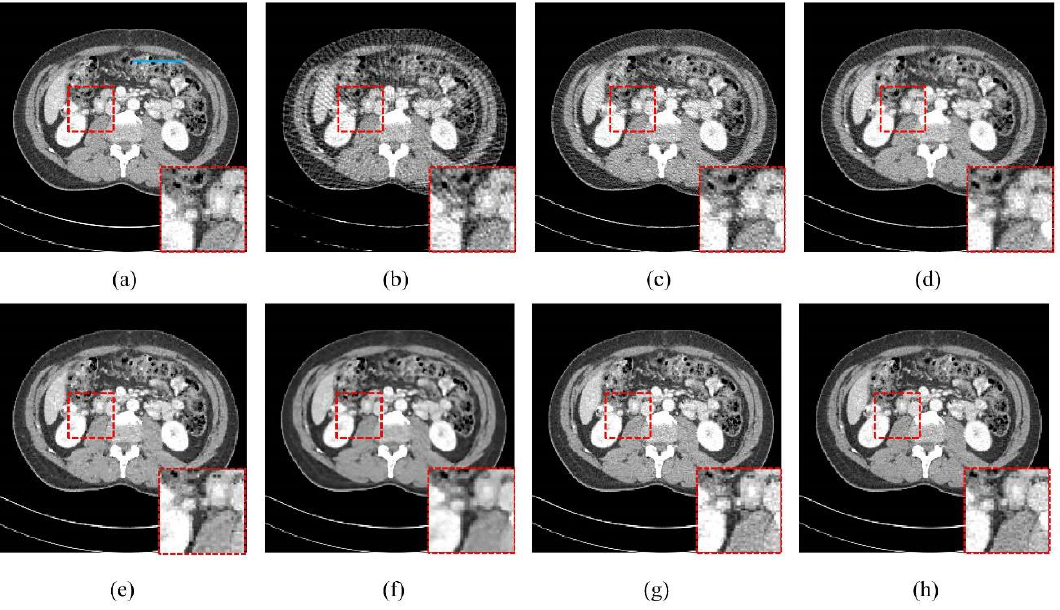
Figure 7. Images reconstructed (from 128 views) using various methods. ( a ) The reference image versus the images reconstructed using ( b ) FBP, ( c ) ART, ( d ) ART-TV, ( e ) TVAL3, ( f ) FBPConvNet, ( g ) LEARN, and ( h ) our network. The profiles along the blue line are shown in Figure 8. The red box indicates the ROI, which is magnified. The display window is [200, 1000] HUs in size.